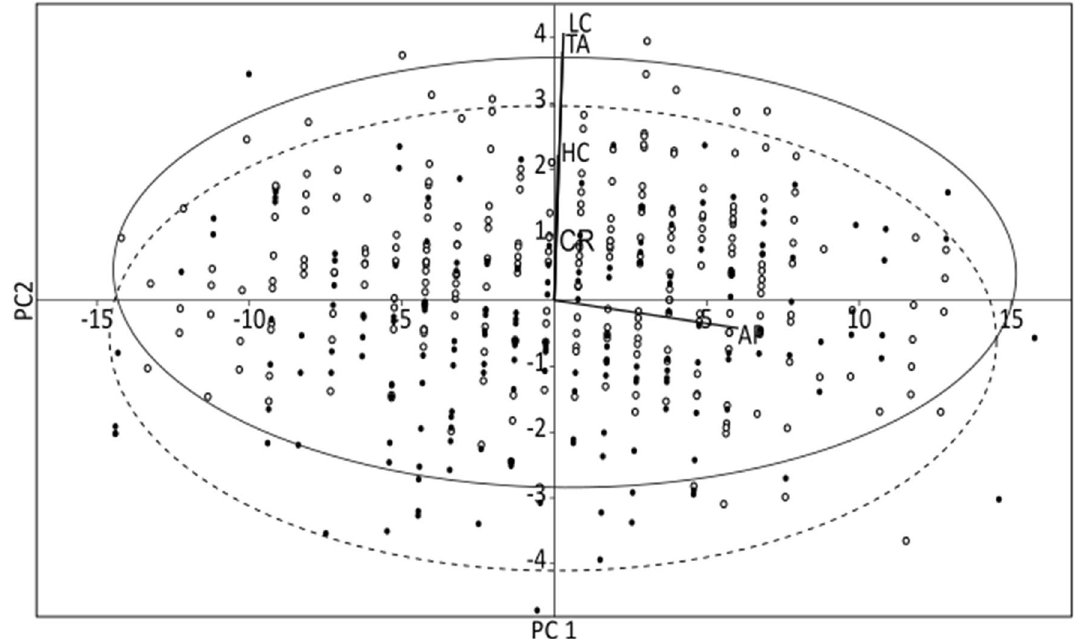
Figure 6. First and second axes of the Euclidian-distance standardized Principal Component Analysis, including standard 95% confidence ellipses, visualizing morphometric variation among adult Barau’s Petrels sampled at the Grand Benare (open circles and dashed ellipse; n = 180) and Piton des Neiges (filled circles and solid ellipse; n = 256) breeding colonies. Morphometric measurements are abbreviated in the biplot as follows: wing chord (AP), culmen length (LC), bill depth at the maximum gonydeal expansion (HC), maxillary unguis length (CR), and tarsus length (TA). Eigen values are as follows: PC1 = 35.56, PC2 = 2.11. Principal